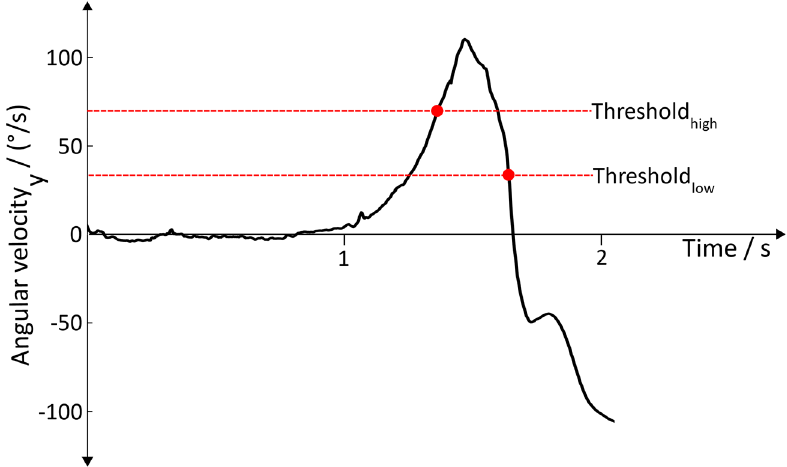
→ y during Toe O ff axis